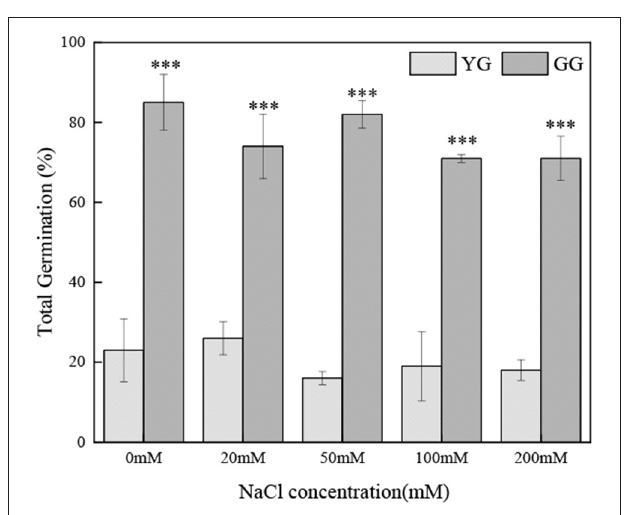
no effect on the total germination percentage. The total germination percentage of GG ranged from 71 to 85% and that of YG ranged from 16 to 23%; the total germination percentage of GG was ∼ four times greater than that of YG ( Figure 4